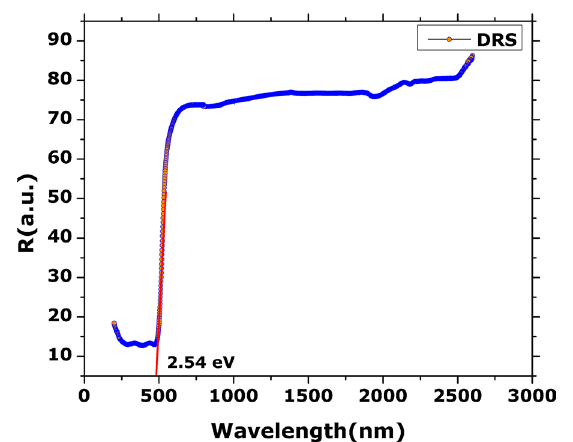
Fig. 3 Diffuse reflectance spectra of BiVO 4